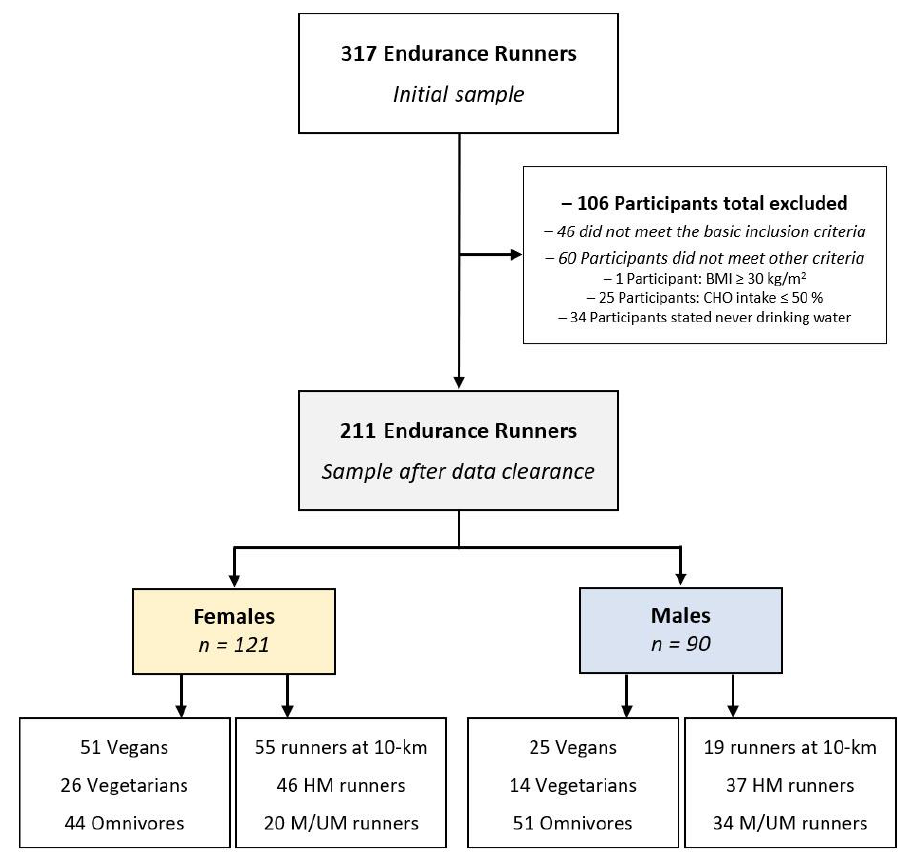
Figure 1. Participants’ enrollment and classifications by sex.